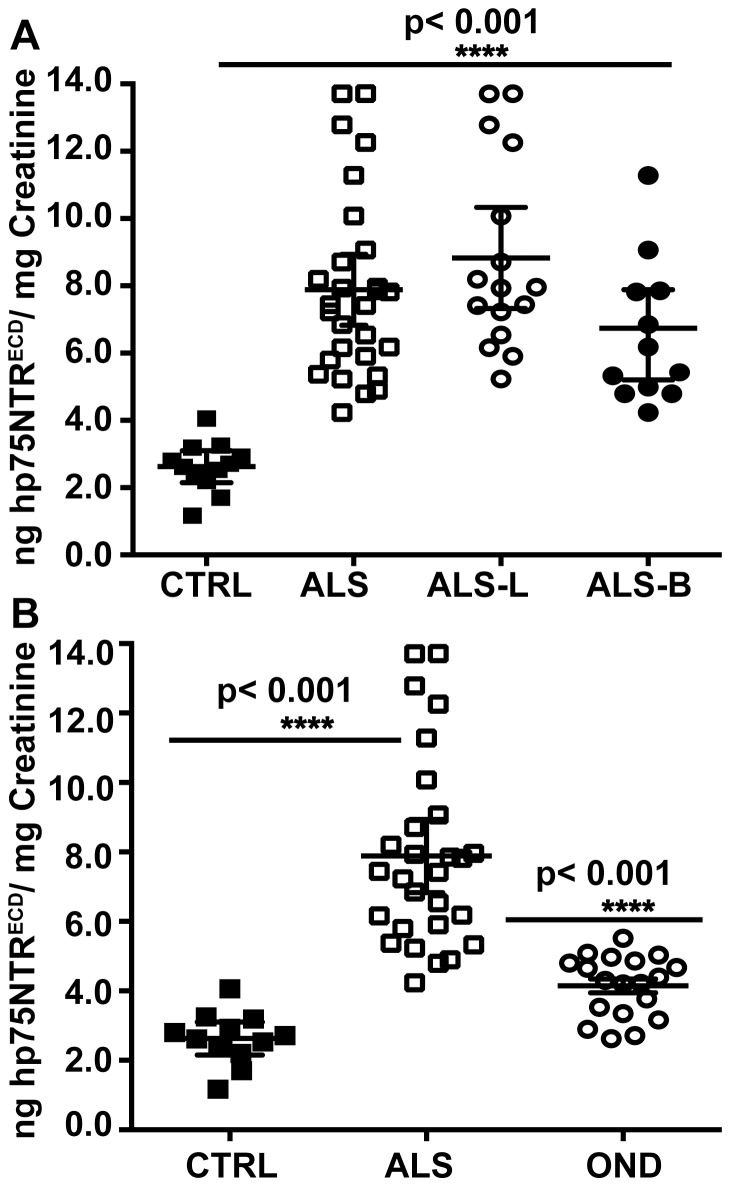
There are significant amounts of p75NTRECD in the urine of ALS patients compared to healthy controls or people with other neurological diseases.A. p75NTRECD levels measured by ELISA were significantly higher in all ALS patients (****; p<0.001, n = 28), including limb (ALS-L; n = 16) and bulbar (ALS-B; n = 12) onset in comparison to healthy controls (n = 12). ALS patients with limb onset disease trended to higher mean levels of p75NTRECD than bulbar onset but this was not significant. B. Levels of p75NTRECD detected in patients with other neurological conditions (OND; n = 19) are not significantly different to that seen in healthy individuals and are significantly lower (***p<0.001, n = 12) than that seen in ALS patients. All samples were assayed four times in quadruplicate. Levels of urinary p75NTRECD were standardised to urinary creatinine and data was analysed with one-way ANOVA and Bonferroni's multiple comparison post-hoc test, with significance at alpha  = 0.01 (1% level).